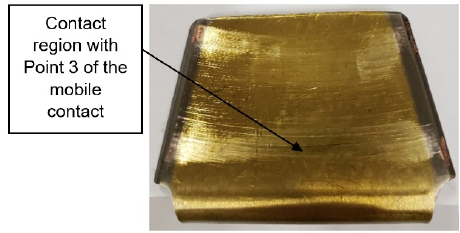
Figure 11. Fixed contact 07 of the voltage regulator.